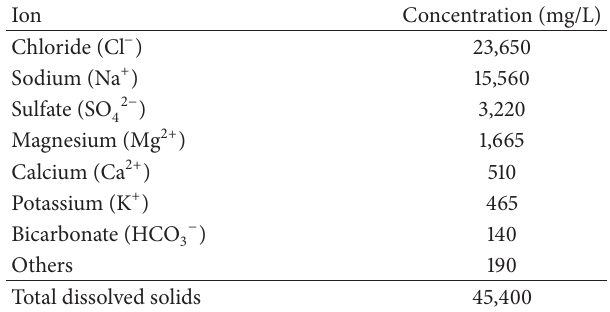
Table 1: Major ion composition of Arabian Gulf Seawater (Kuwait).